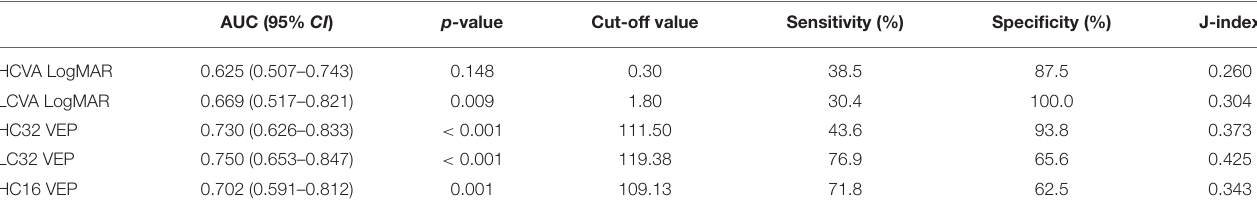
HCVA, high-contrast visual acuity; LCVA, low-contrast visual acuity; VEP, visual evoked potential; ON, optic neuritis; AUC, area under the receiver operating characteristic curve; CI, confidence interval.